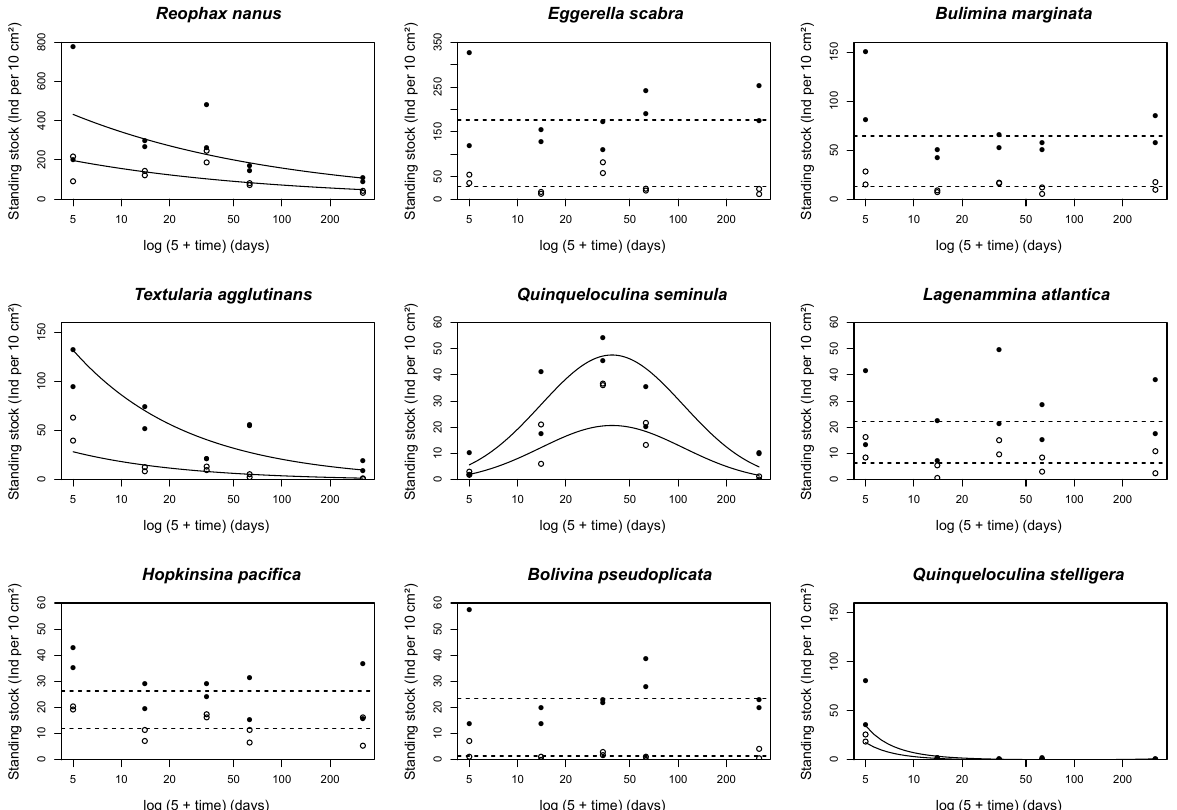
Fig. 3. Standing stock variation with time and sampling depth (full circles: 0–5cm, open circles 0–0.5cm) for the nine major species. The lines are estimated after the model-type 2, full lines indicating a significant effect of time and dashed lines indicating a nonsignificant effect of time. Two lines are drawn for the significantly different depth